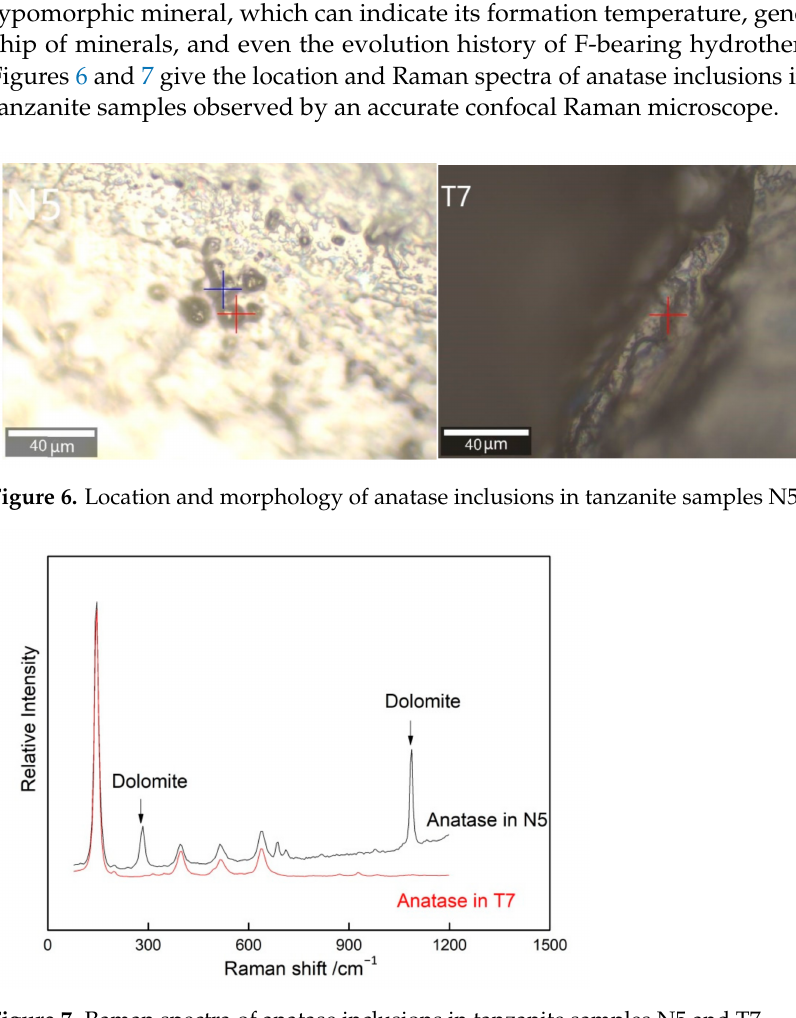
Figure 7. Raman spectra of anatase inclusions in tanzanite samples N5 and